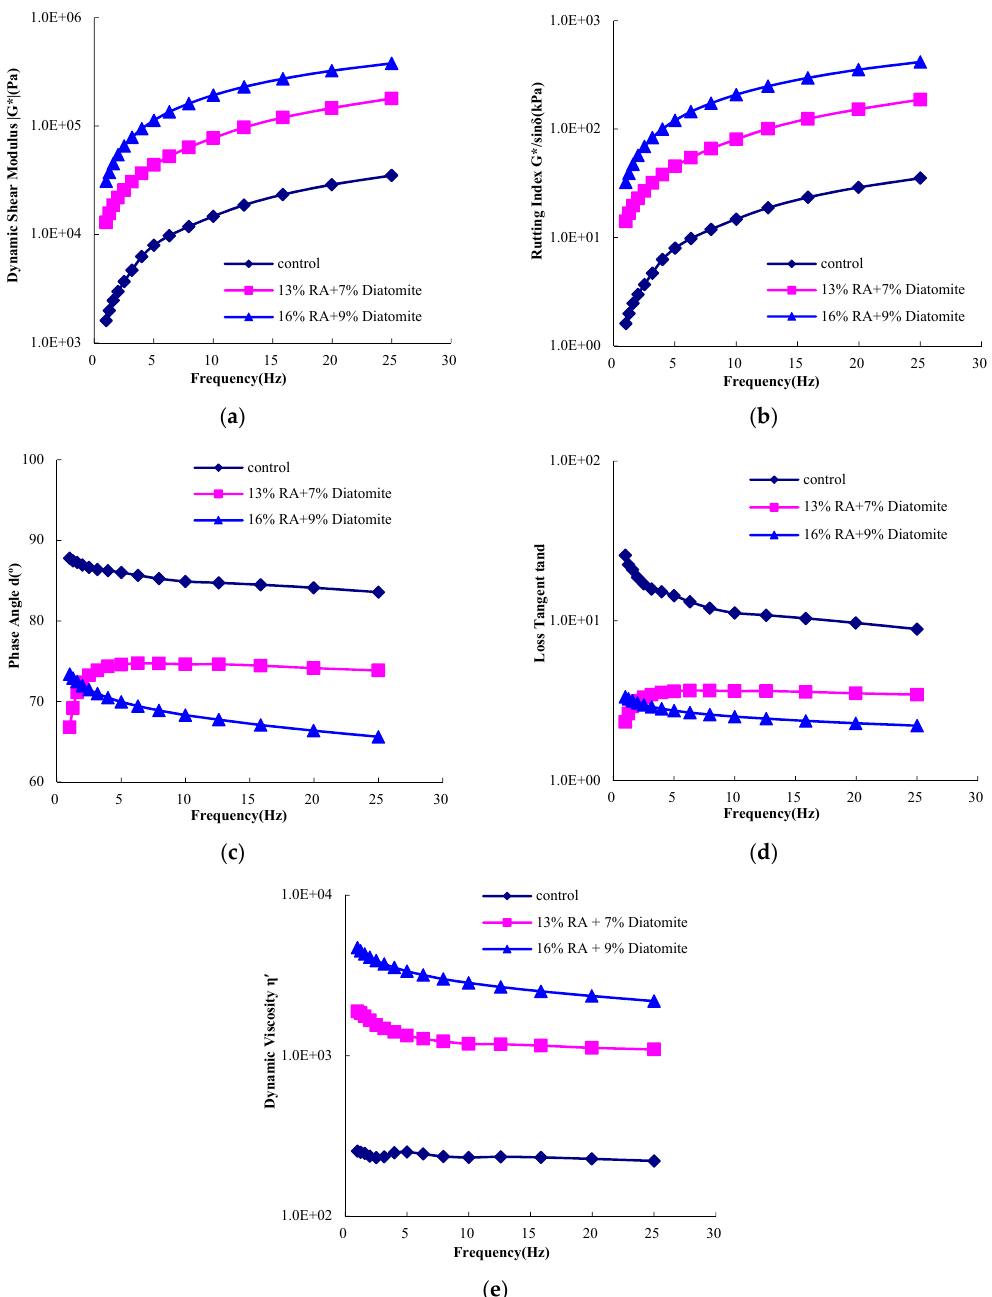
Figure 4. The frequency sweep results: ( a ) dynamic shear modulus; ( b ) rutting index; ( c ) phase angle; ( d ) loss tangent; and ( e ) fatigue index.